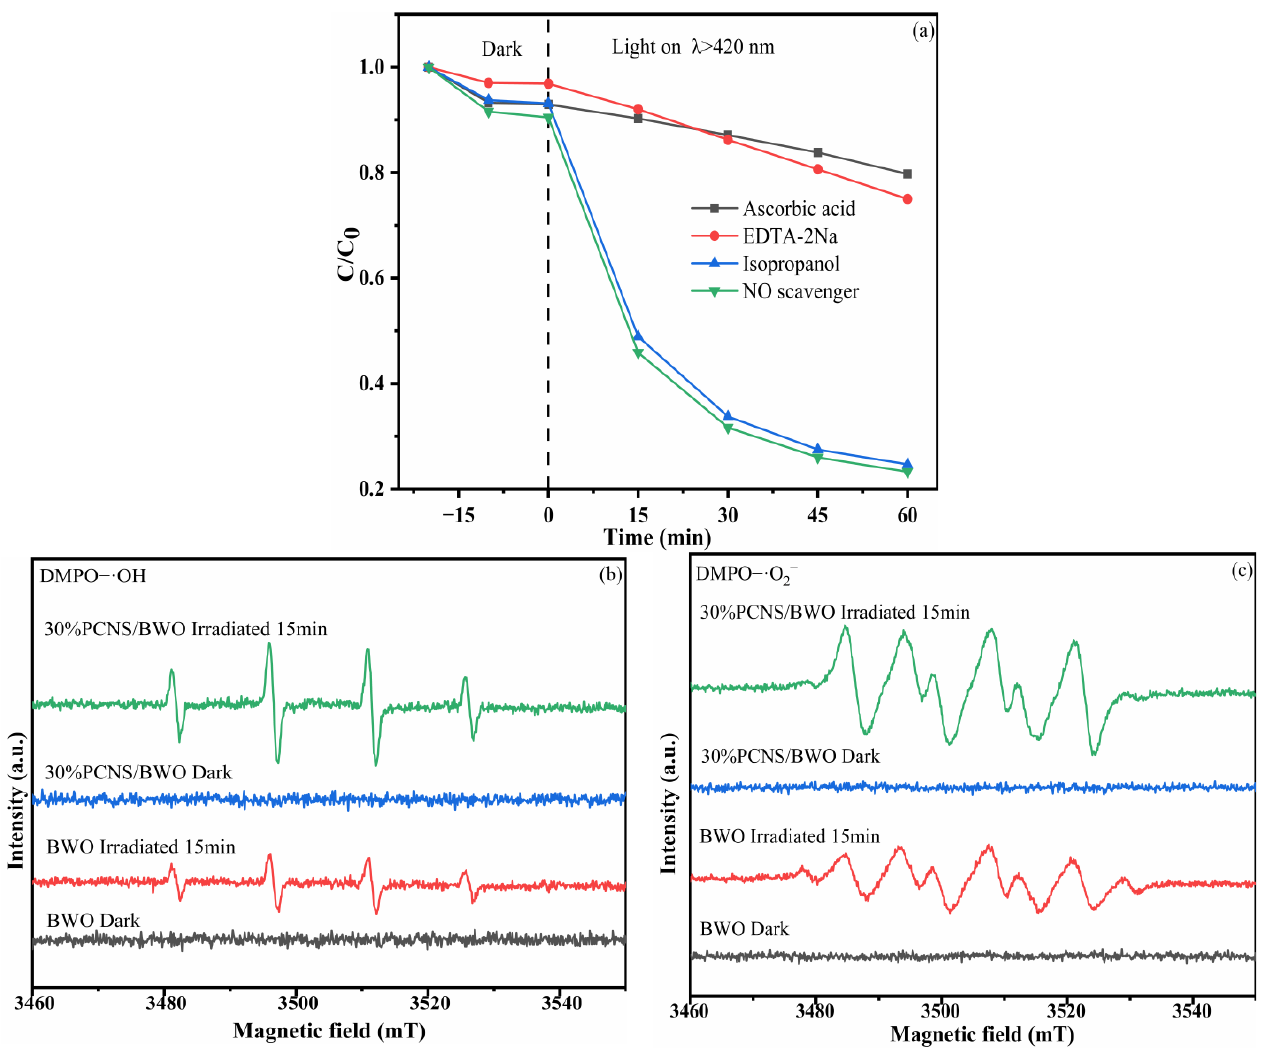
Figure 13. ( a ) Effects of different scavengers on the degradation of TC-HCl catalyzed by 30% PCNS/BWO; ESR spectra of ( b ) DMPO- •OH and ( c ) DMPO- •O 2 −